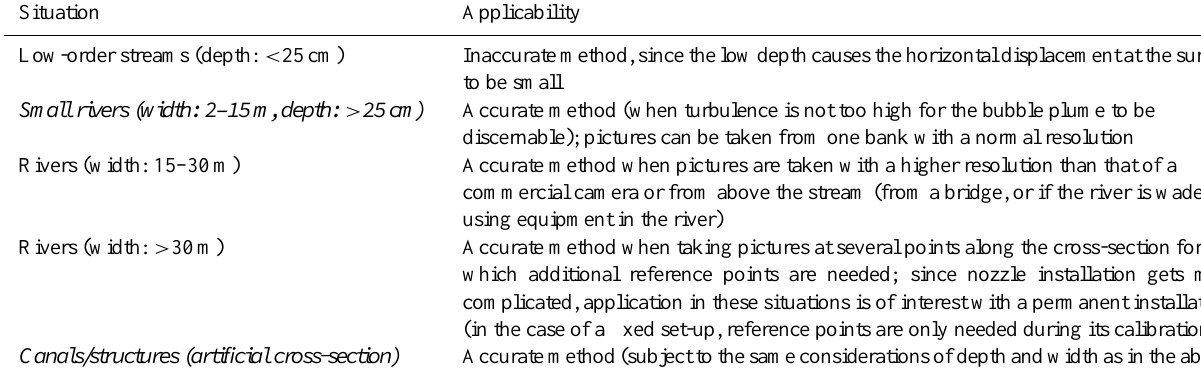
Table 4. Applicability of the rising bubble technique for various situations (situations in italics were actually applied). Situation